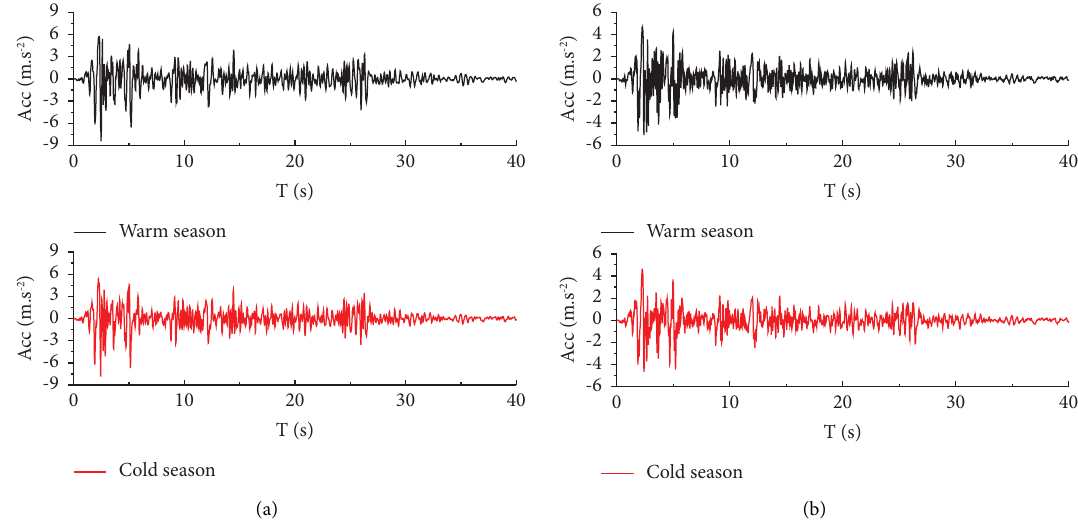
Figure 6: Te acceleration time history curve of the characteristic point in diferent seasons: (a) characteristic point S ; (b) characteristic point T